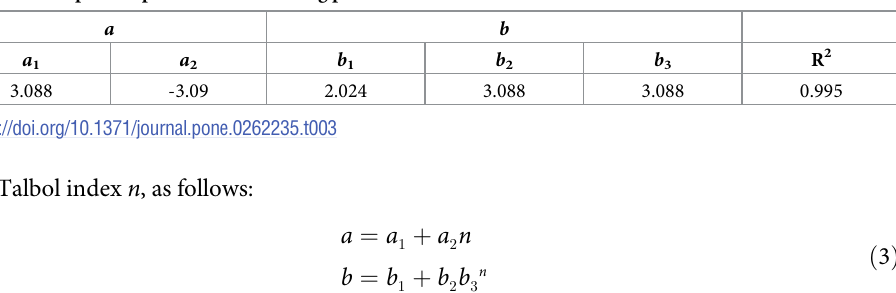
Table 3. Compaction parameters and fitting parameters of n .